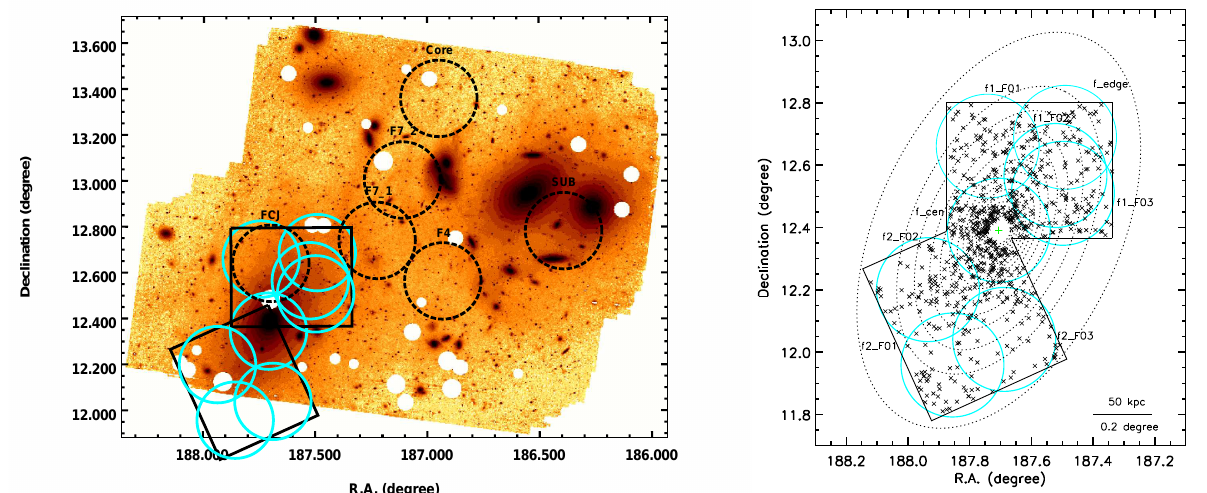
Figure 1. ( Left ): Image of the core of the Virgo cluster [7] with the positions of the FLAMES fields studied in this work (cyan circles) and in previous surveys (dotted black circles, see [18]). Black squares represent the Suprime-Cam survey fields used for the extraction of the photometric planetary nebulas (PN) candidates [16]; ( Right ): Enlarged view of the M87 halo (black rectangles). FLAMES pointings (cyan circles) and PN candidates from the photometric survey (black asterisks; [16]) are plotted over the isophotes of the M87 halo light [13]. The green cross depicts M87’s centre. North is up, East is to the